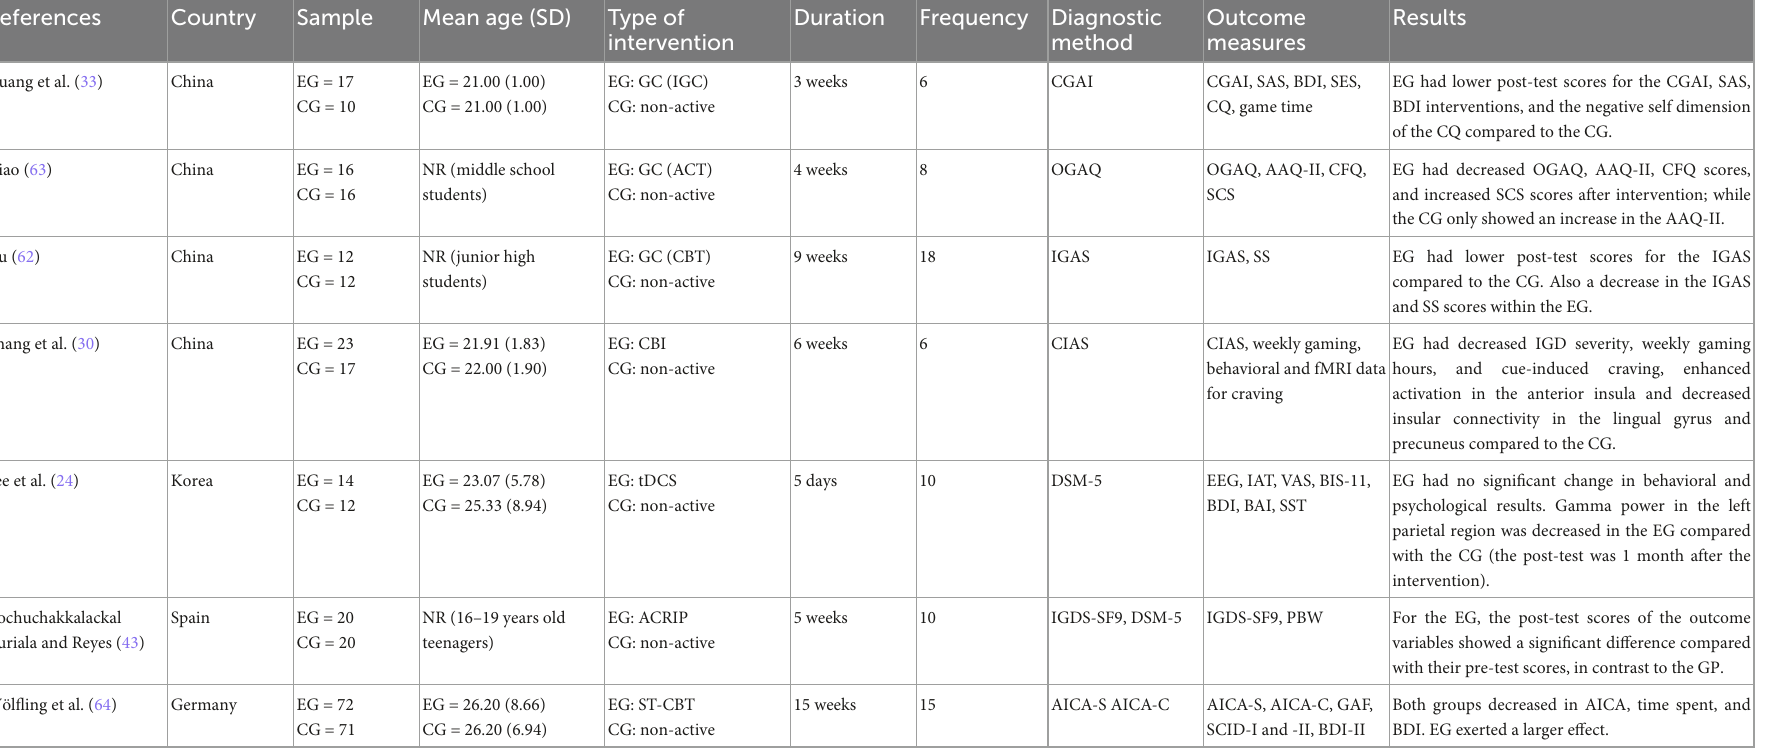
TABLE 2 Characteristics of the included